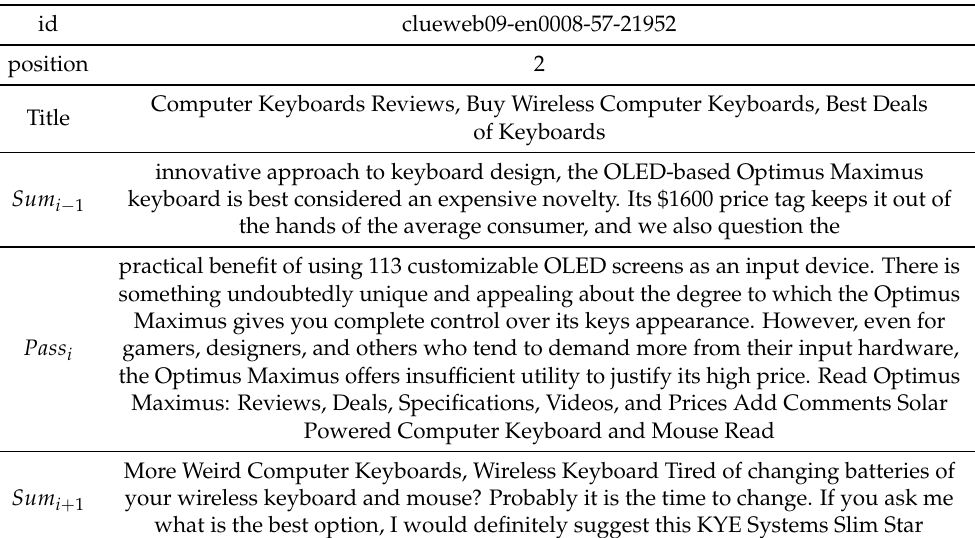
Table 1. Example of Concatenated Multi-layer Contextual Passage (docid: clueweb09-en008-57-21952 passid:passage-2).